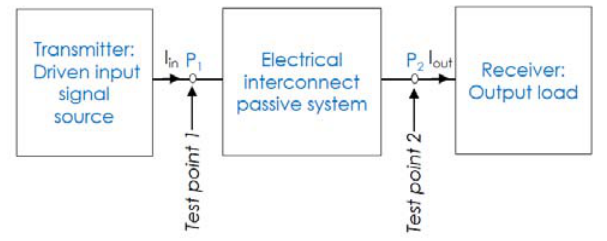
Fig. 3: Diagram of the Tx-Rx